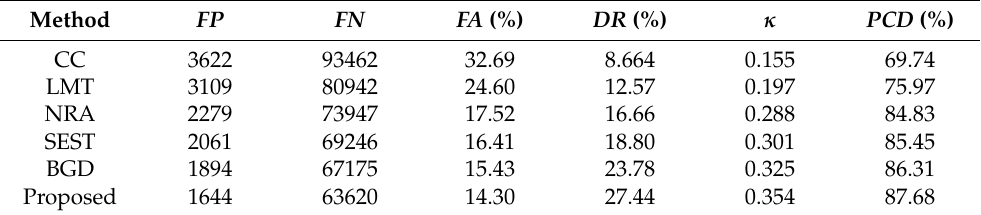
Table 3. Comparison of results from all the six methods using dataset 3 before median filtering.